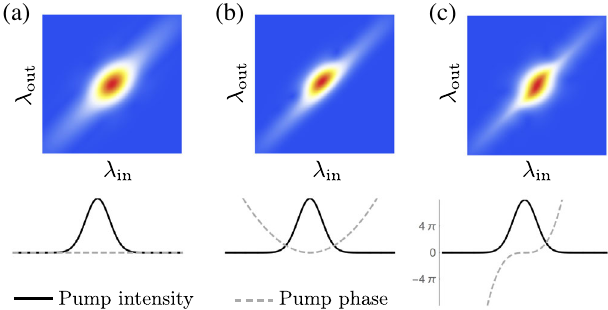
ð ω ; ω 0 Þ . ð b Þ